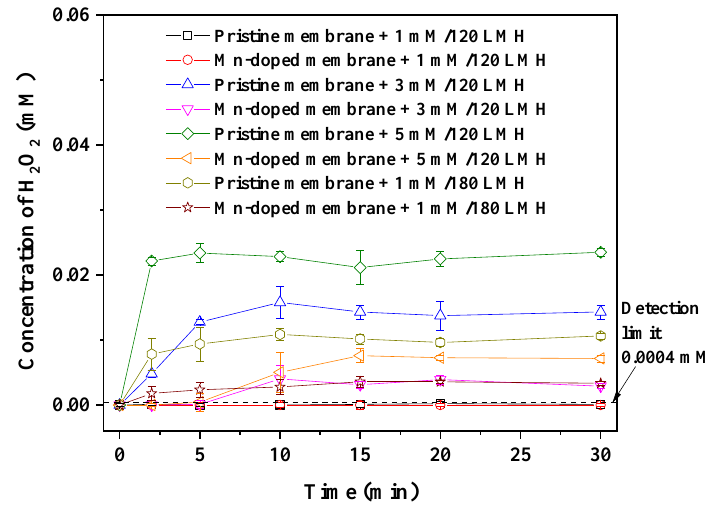
Figure 5. Effect of H 2 O 2 backwash mode on the concentration of H 2 O 2 in the membrane